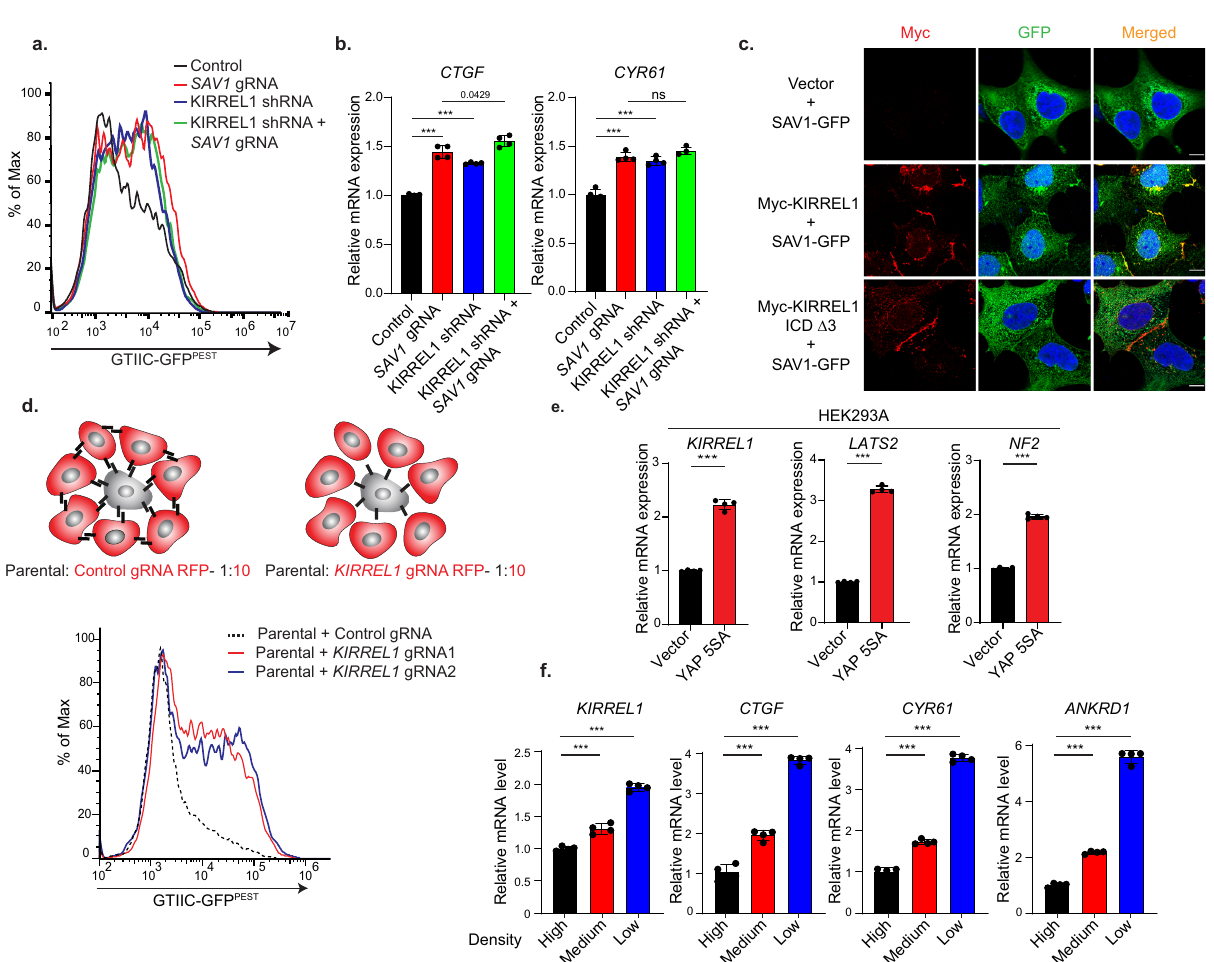
Fig. 4 KIRREL1 regulates Hippo signaling through recruiting SAV1 to the cell – cell contact sites. a Dual inhibition of KIRREL1 and SAV1 has no additive effect on GTIIC-GFP PEST reporter. HEK293A GTIIC-GFP PEST Cas9 cells with inhibition of KIRREL1 , SAV1 or both were subjected to fl ow cytometry analysis. b Dual depletion of KIRREL1 and SAV1 has no additive effect on expression of YAP target genes. Cells were plated at medium density (0.5 × 10 6 cells/well) in 12-well plate and subjected to qRT-PCR analysis 48 h of post cell plating. Data represent mean ± SD, n = 4, error bars denote the SD between four biological replicates; Unpaired two-tailed t -test was used to determine the statistical signi fi cance, *** p value < 0.001, ns — 0.0978. c Overexpression of KIRREL1 promotes localization of SAV1 to the cell-cell contacts. HEK293A cells were co-transfected with plasmids encoding GFP-tagged SAV1 and Myc- tagged KIRREL1 and subjected to immuno fl uorescence assay using anti-Myc and anti-GFP antibodies. DAPI was used to mark the nuclei. Scale bar 10 µ m. d Knockout of KIRREL1 enhances YAP activity in neighboring cells. HEK293A GTIIC-GFP PEST Cas9 cells and HEK293A GTIIC-GFP PEST Cas9 cells transduced with lentivirus expressing RFP and control or KIRREL1 gRNAs were mixed at 1:10 ratio, co-cultured for 2 days, and subjected to FACS analysis. The signal of GTIIC-GFP PEST in RFP-negative parental cells is plotted . e Active YAP induces expression of KIRREL1 mRNA. HEK293A cells stably expressing vector or YAP 5SA mutant were plated at medium density (0.5 × 10 6 cells/well) in 12-well plate and subjected to qRT-PCR analysis 48 h of post cell plating. LATS2 and NF2 were used as positive control. The data represent mean ± SD, n = 4, error bars denote the SD between four biological replicates; Unpaired